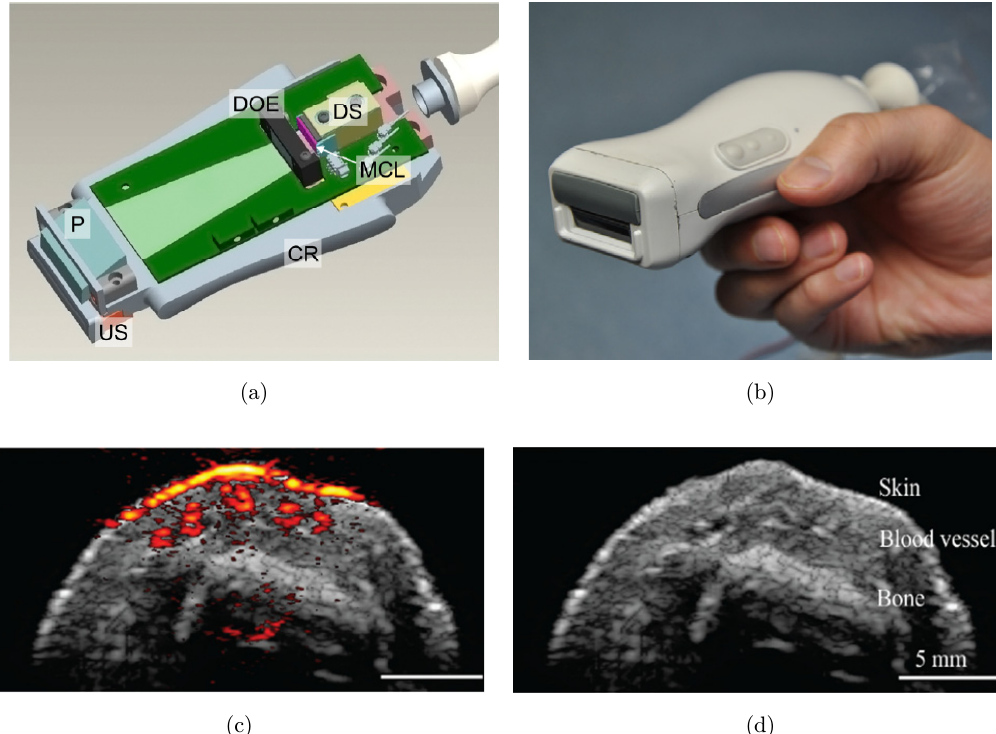
Fig. 4. (a) Schematic of the handheld probe. US, ultrasound array transducer; P, de°ecting prism; DOE, di®ractive optical elements; DS, diode stack; MCL, micro-cylindrical lenses; CR, aluminum cooling rim. (b) External shape of the handheld probe, (c) photoacoustic/ultrasound image of a human proximal interphalangeal joint, and (d) ultrasound image of a human proximal interphalangeal joint (images adapted from Ref.